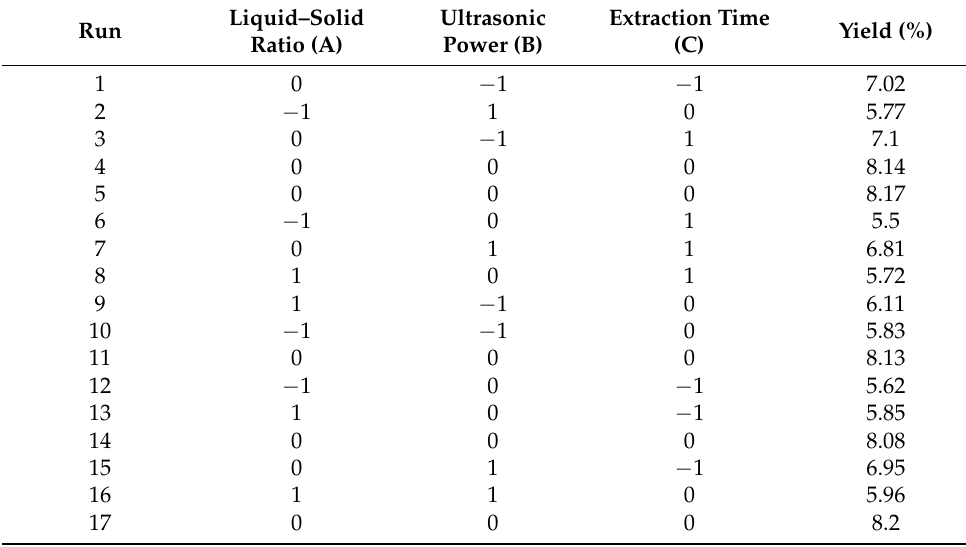
Table 2. Box–Behnken design (BBD) matrix of the three variables in coded units and response values for the extraction rate of GPPs.